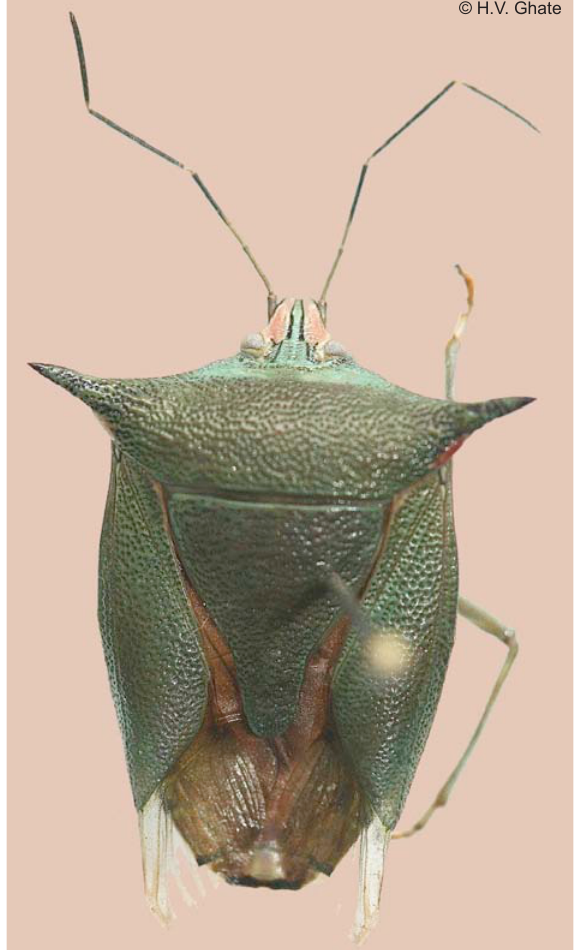
Image 7. Sabaeus humeralis , dorsal view.